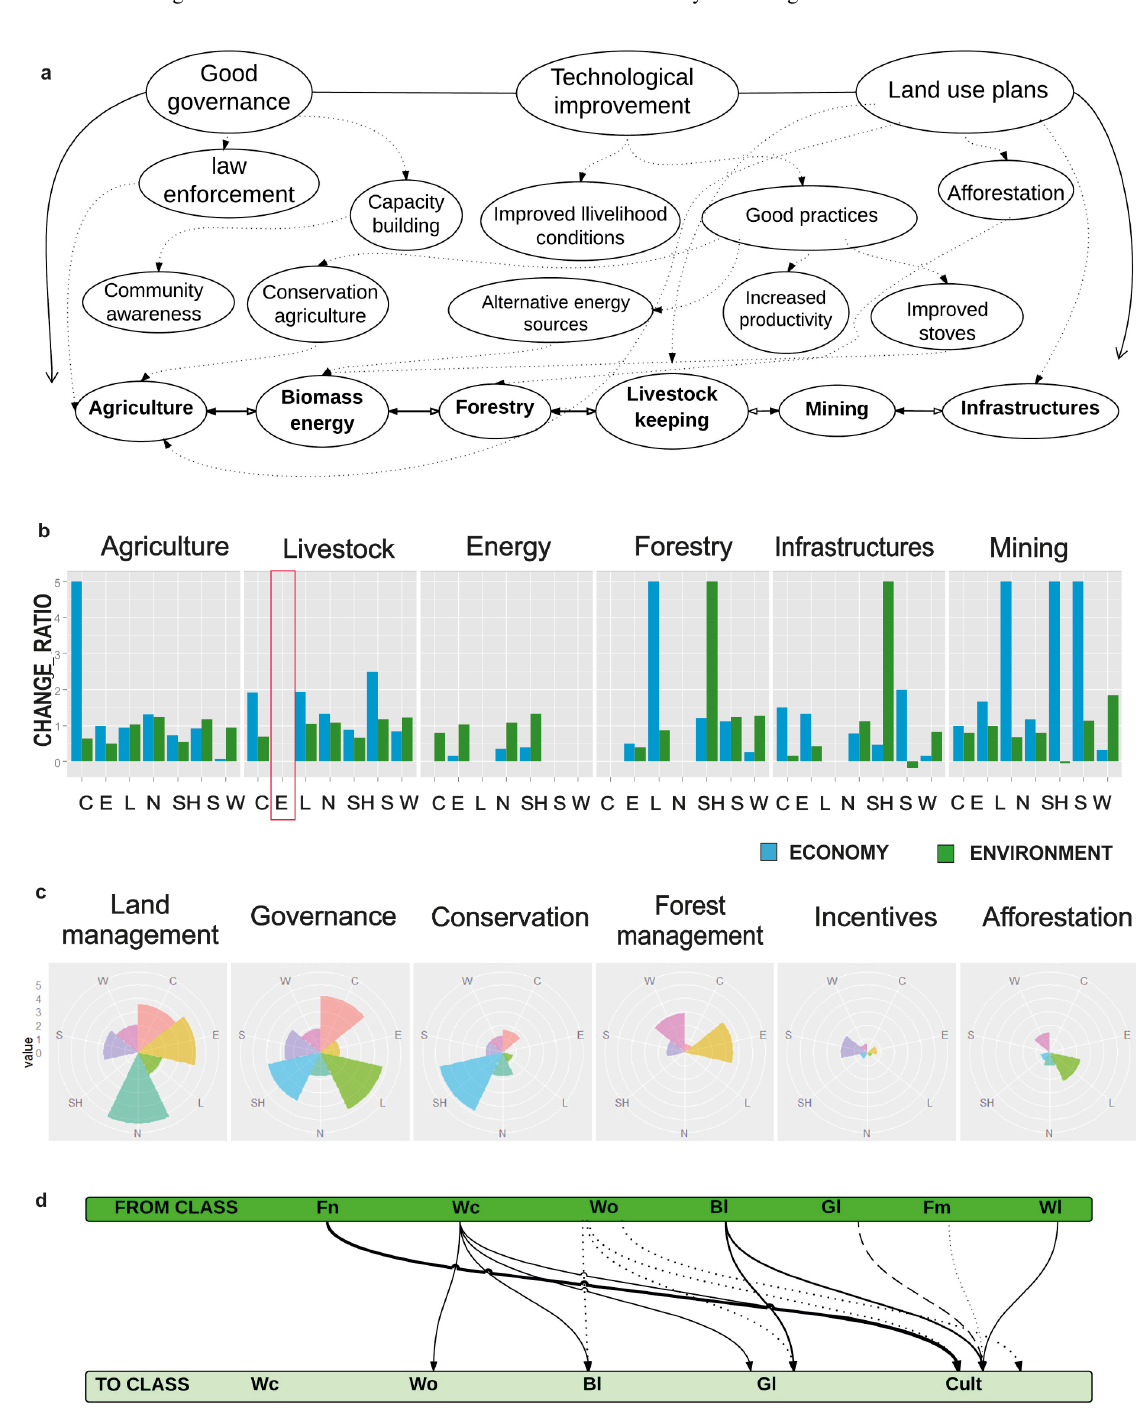
Fig. 6 . Synthesis of the qualitative and quantitative outputs from multistakeholder workshops, for the green economy (GE) scenario. Socioeconomic-environmental factors drive sectoral trajectories across units (a), determining different rates of changes between GE scenario (b). Direct drivers related to socioeconomic trajectories (c) reduce degradation and deforestation (d). Legend and symbols as in Figure 5. The red rectangular frame indicates the lack of envisaged GE scenario for the livestock sector in the Eastern Zone, symptomatic of challenges for coexistence between traditional and modern ways of